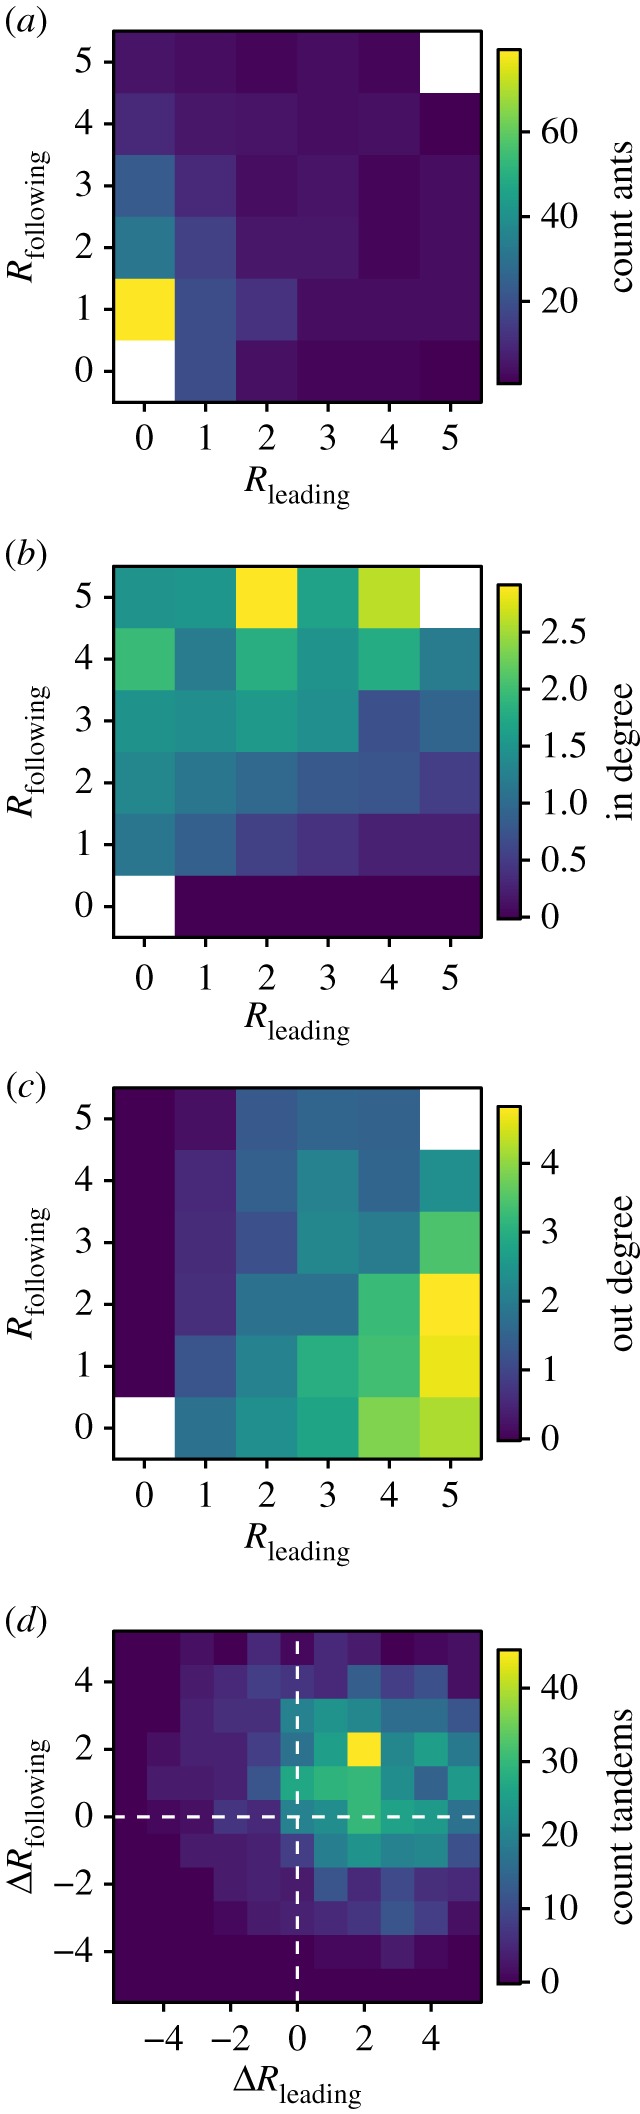
Assortative matching between tandem leaders and followers. (a) Joint frequency distribution of the leading and following reliability, fant(Rleading, Rfollowing). Each cell gives the count of the number of ants (over all colonies) that respectively led and followed Rleading and Rfollowing tandems. (b) Ants that were reliable followers but unreliable leaders had high mean in-degree. (c) Ants that were reliable leaders but unreliable followers had high mean out-degree. (d) Joint frequency distribution of the differences in individual leading and following reliability between the leader and follower ant in every tandem pair, ftandObs(ΔRleading, ΔRfollowing). (Online version in colour.)